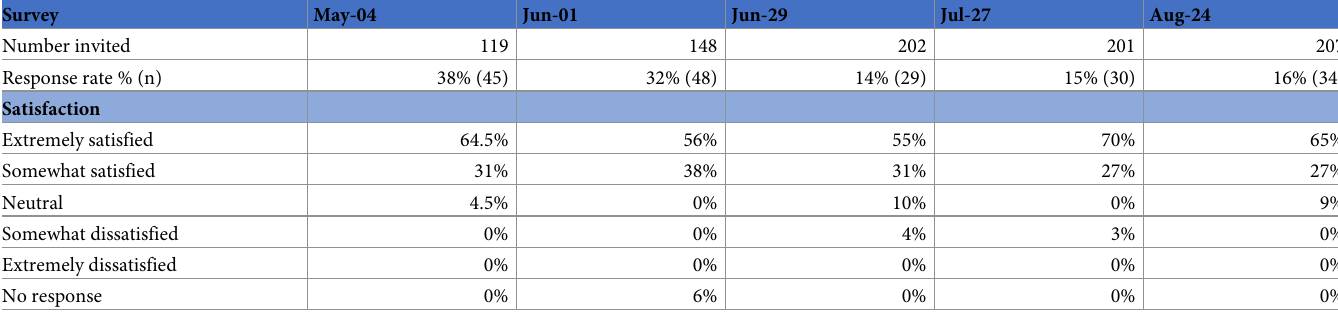
Table 2. Survey response rate and levels of